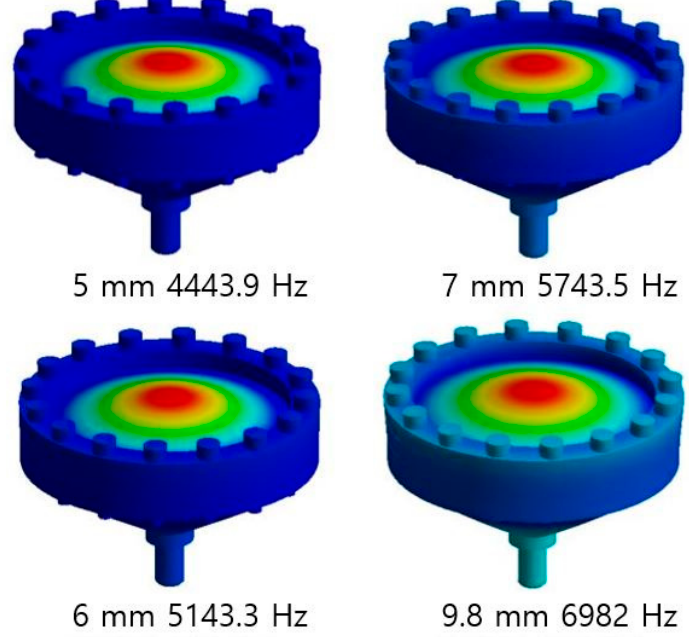
Figure 9. Modal analysis results according to thickness of resonator.